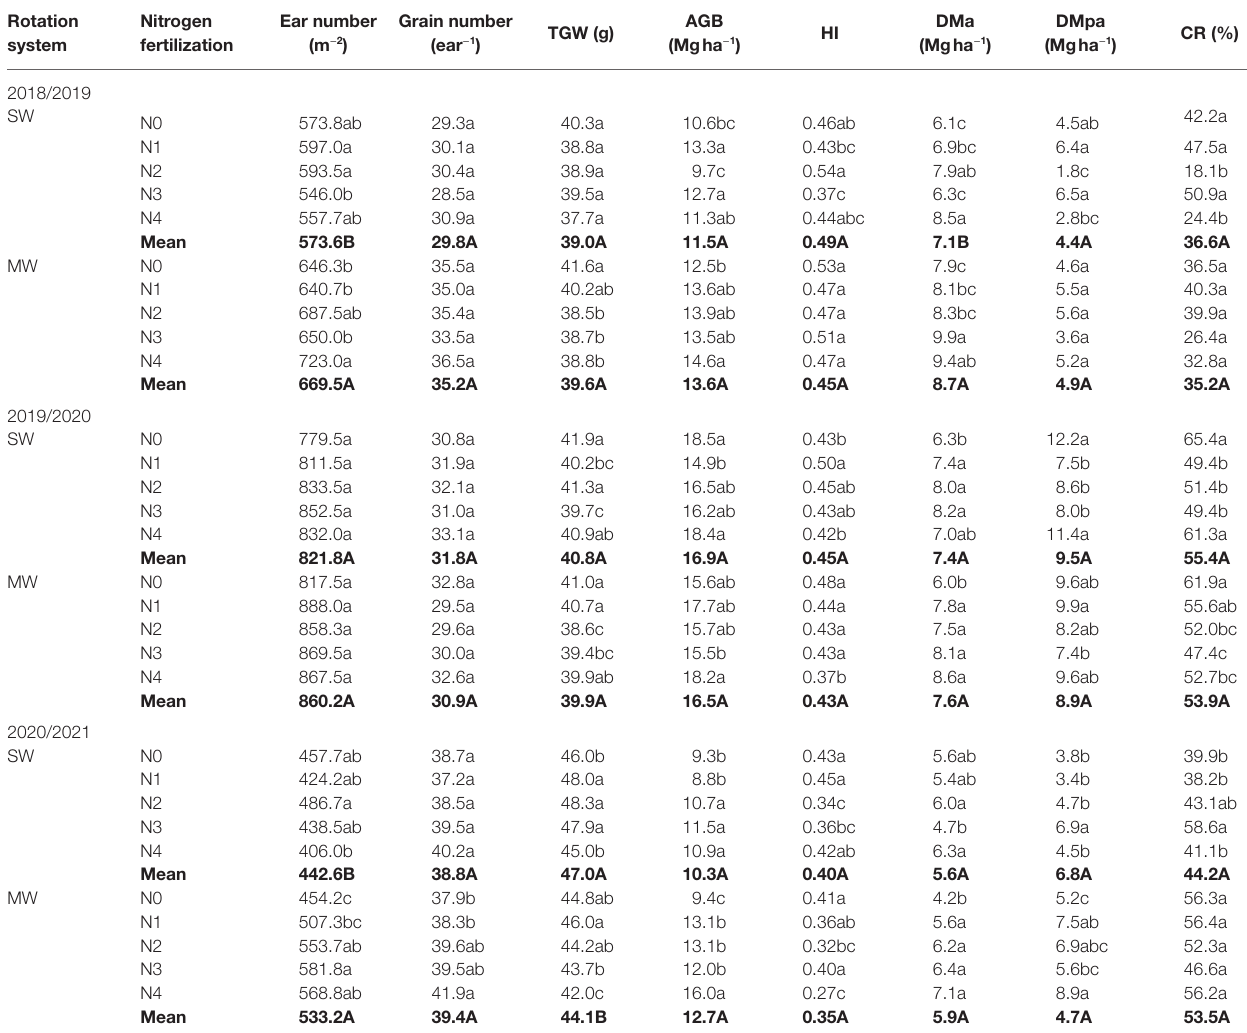
TABLE 2 | Yield components, dry matter accumulation at anthesis (DMa), dry matter accumulation during post-anthesis (DMpa), and contribution ratio of DMpa to grain yield (CR) of winter wheat in summer soybean − winter wheat (SW) and summer maize − winter wheat (MW) rotation systems under five N application rates. Rotation Nitrogen system